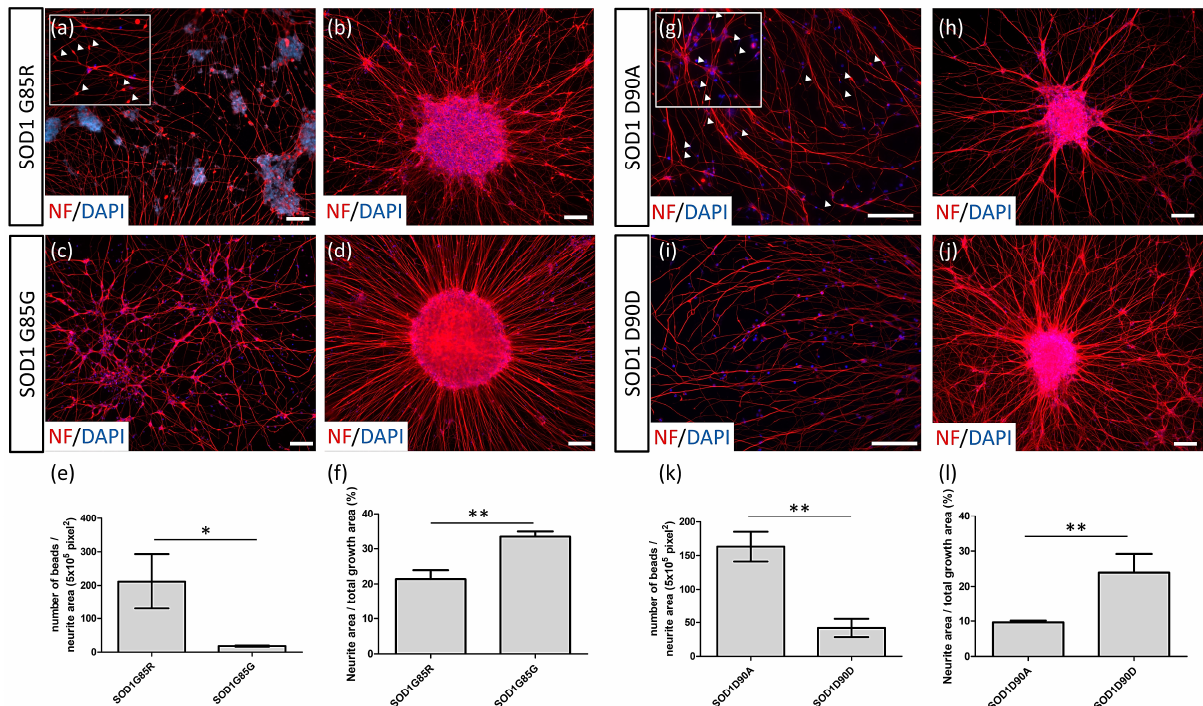
Figure 3. Nerve fiber beads and neurite degeneration in SOD1 ALS MNs. ( a – d ) Nerve fiber beads ( a ) and neurite density ( b ) of SOD1 G85R and SOD1 G85G (nerve fiber beads: c; neurite density: d) MNs identified with NF immunocytochemistry staining. ( e ) Number of nerve fiber beads of SOD1 G85R and SOD1 G85G MNs at day 35 of differentiation. ( f ) Neurite density of SOD1 G85R and SOD1 G85G MNs at day 28 of differentiation. ( g – j ) Nerve fiber beads ( g ) and neurite density ( h ) of SOD1 D90A and SOD1 D90D (nerve fiber beads: ( i ); neurite density: ( j )) MNs. ( k ) Number of nerve fiber beads of SOD1 D90A and SOD1 D90D MNs at day 35 of differentiation. ( l ) Neurite density of SOD1 D90A and SOD1 D90D MNs at day 28 of differentiation. The nerve fiber beads are indicated by arrow heads. * p < 0.05 and ** p < 0.01. Scale bar, 100 µ